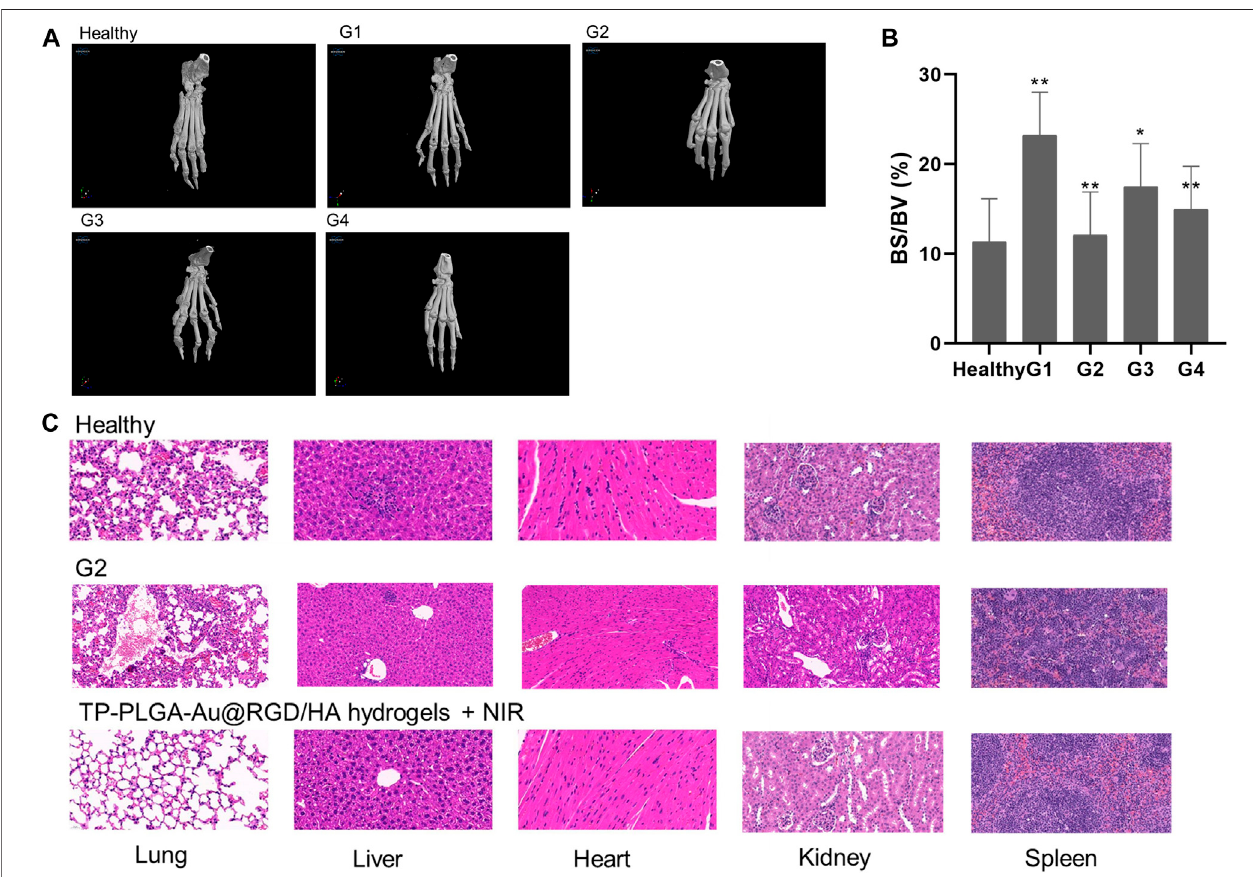
FIGURE 9 | (A) Micro-computed tomography images of hind paws of CIA mice in different treatment groups. (B) Effects of G4 on bone destruction in CIA mice. Bone volume/total volume (BV/TV; %) in CIA mice. * p < 0.05 versus G1; ** p < 0.01 versus G1. (C) Histological sections of major organs extracted on day 28 after administration of health (top), TP-PLGA-Au@RGD/HA hydrogels combined with NIR irradiation (bottom, G4) and G2. Images were acquired under ×20 magni fi